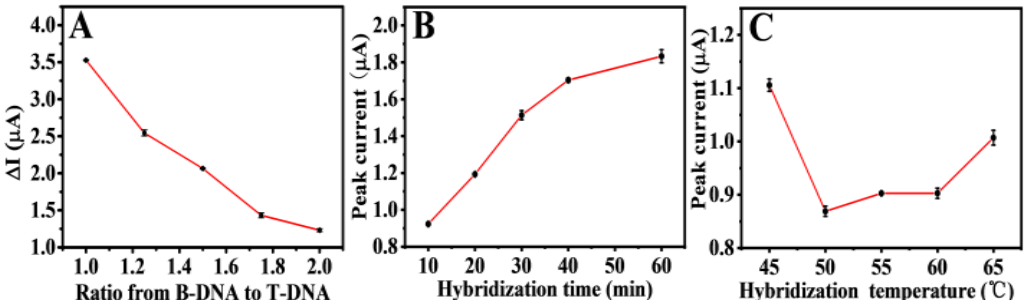
Figure 6. Optimization of the ratio concentration of B-DNA to T-DNA ( A ), hybridization time ( B ), and hybridization temperature ( C ) for the detection of T-DNA on the constructed Au/NiFe-LDH/GCE biosensor. Error bars = SD (n = 3).